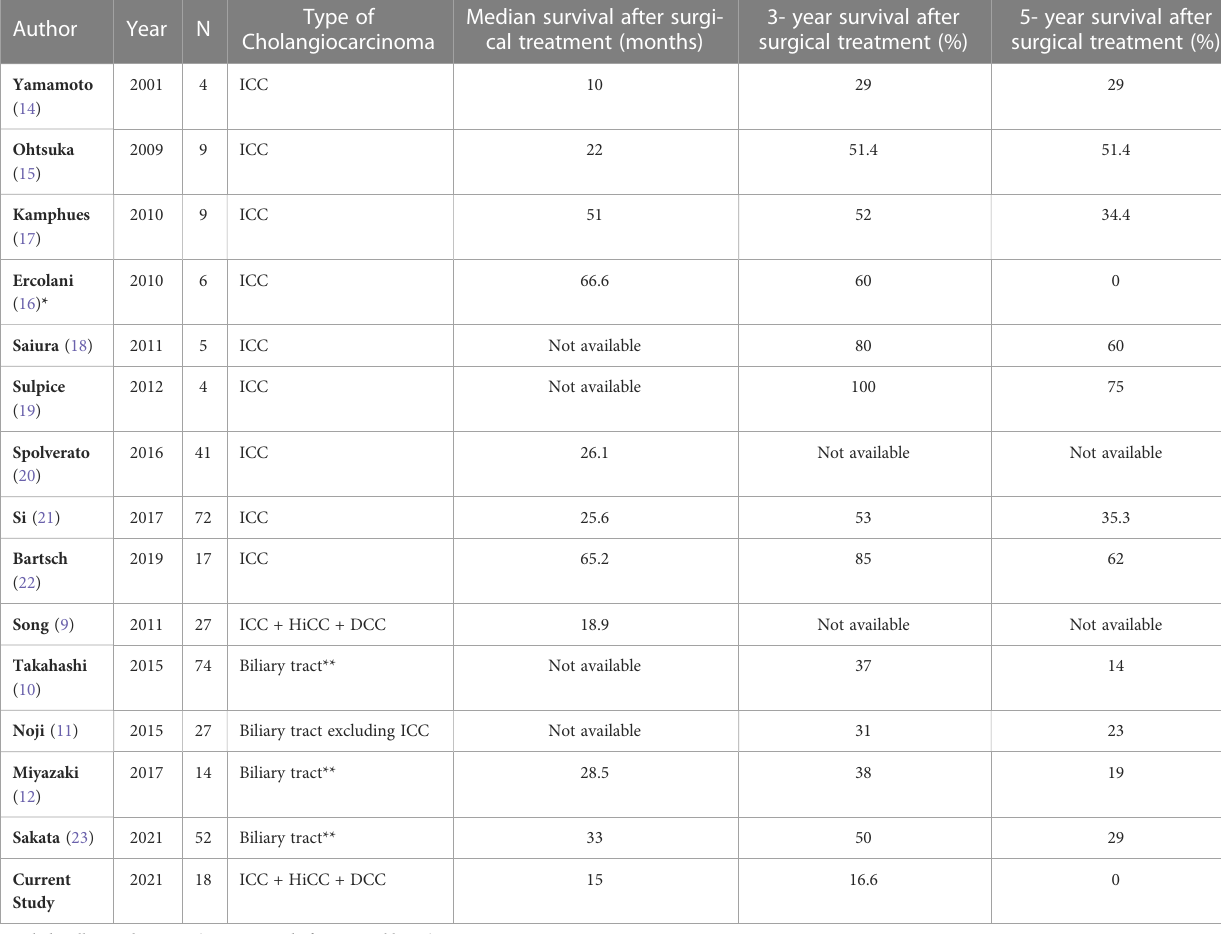
TABLE 4 Published studies of the surgical treatment for cholangiocarcinoma